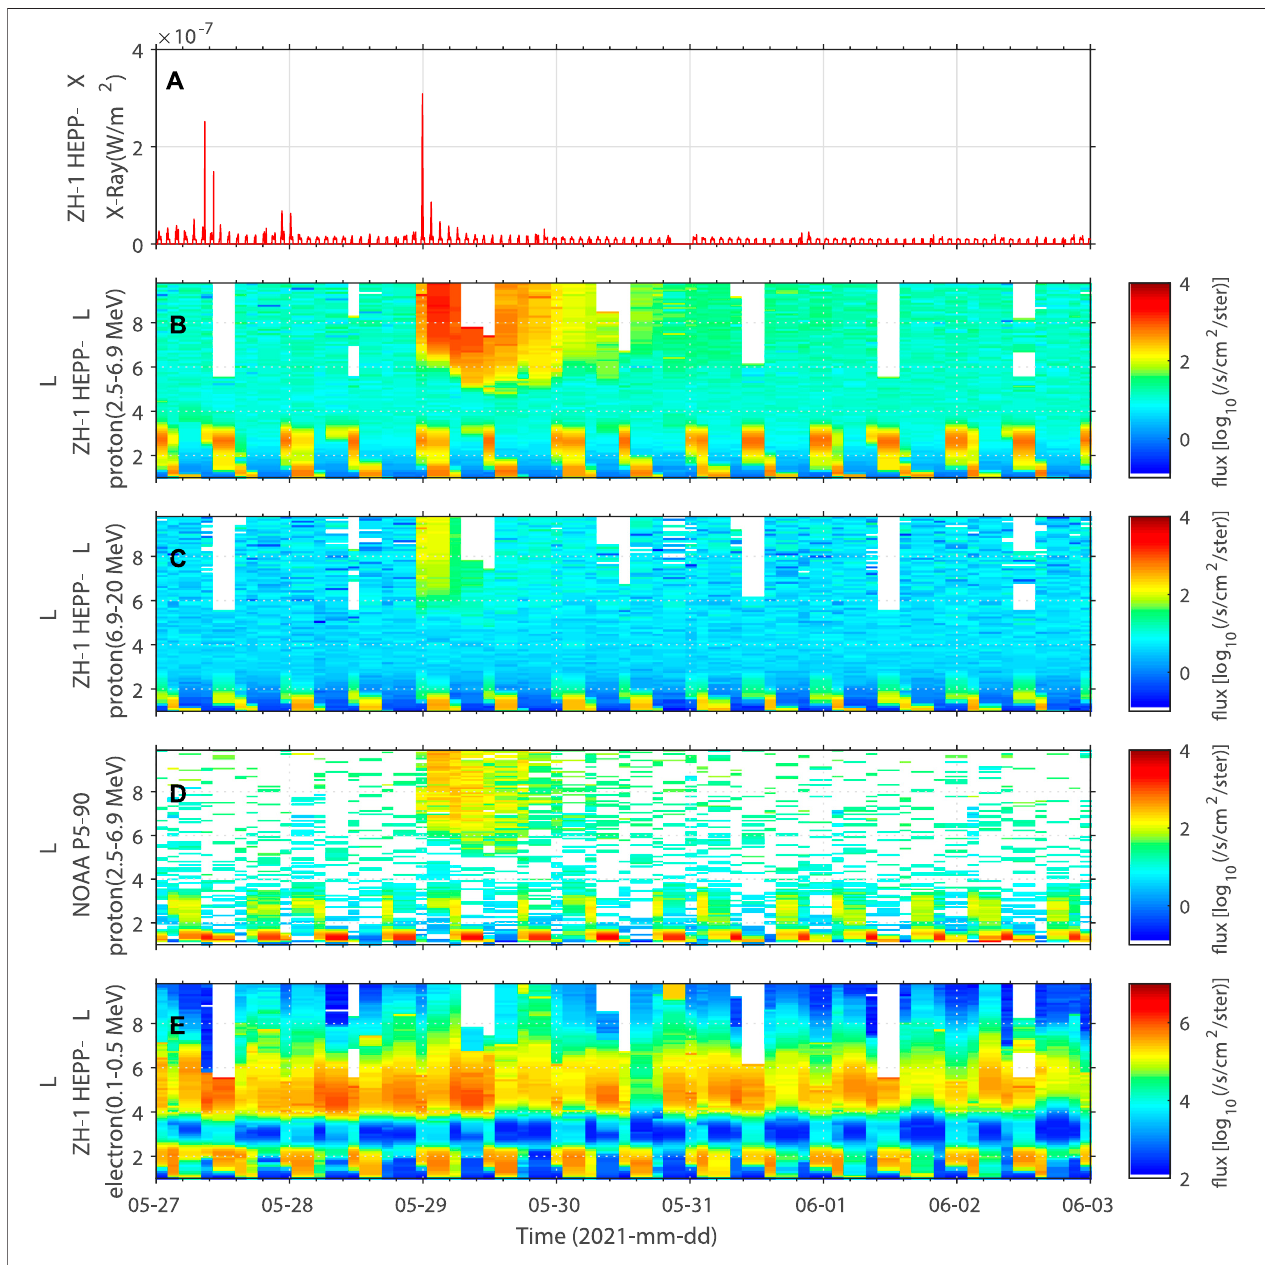
FIGURE4| TheevolutionofX-rays,protons,andelectrons duringtheimpulsiveSPEfrom27May2021to3June2021. (A) X-ray fl uxesobservedbyHEPP-X. (B) , (C) The proton fl uxes observed by ZH-1 withenergiesof 2.5 – 6.9 MeV and 6.9 – 20 MeV. (D) The proton fl uxes from theNOAA-19 satellite. (E) 0.1 – 0.5 MeV electron fl ux distribution from